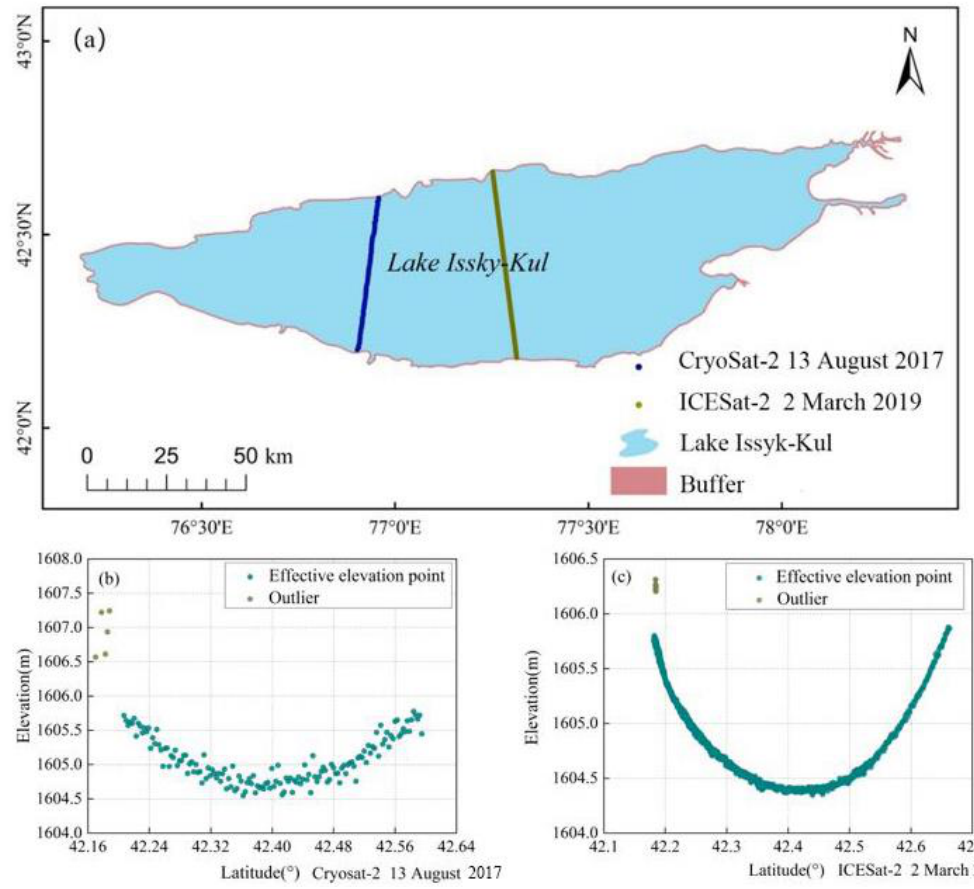
Figure 5. An example of outlier removal. ( a ) The location of ground tracks of two satellite altimeters, and outlier removal for ( b ) CryoSat-2 and ( c ) ICESat-2 altimetry data. Finally, the overall screening of all daily water levels was operated by the 3 σ criterion to further obtain the monthly average water level and the annual average water